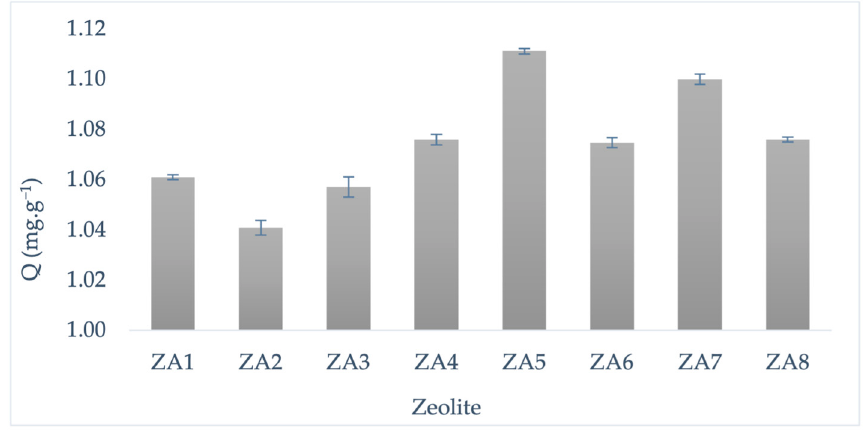
Figure 7. MB + adsorption capacity onto synthesized LTA zeolites.